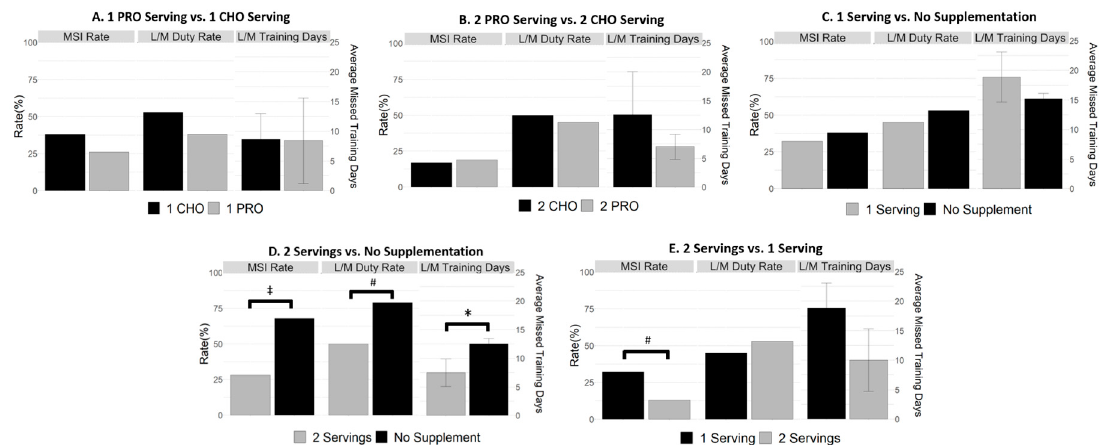
Figure 2. MSI Rates, Limited/Missed Duty Rates, Limited/Missed Training Days ( A – E ) Abbreviations: Protein (PRO), Carbohydrate (CHO), Limited/Missed Duty Rates (L/M Duty Rates), Limited/Missed Table 2. Summary of MSI Rates and Limited/Missed Duty Rates. Group MSI